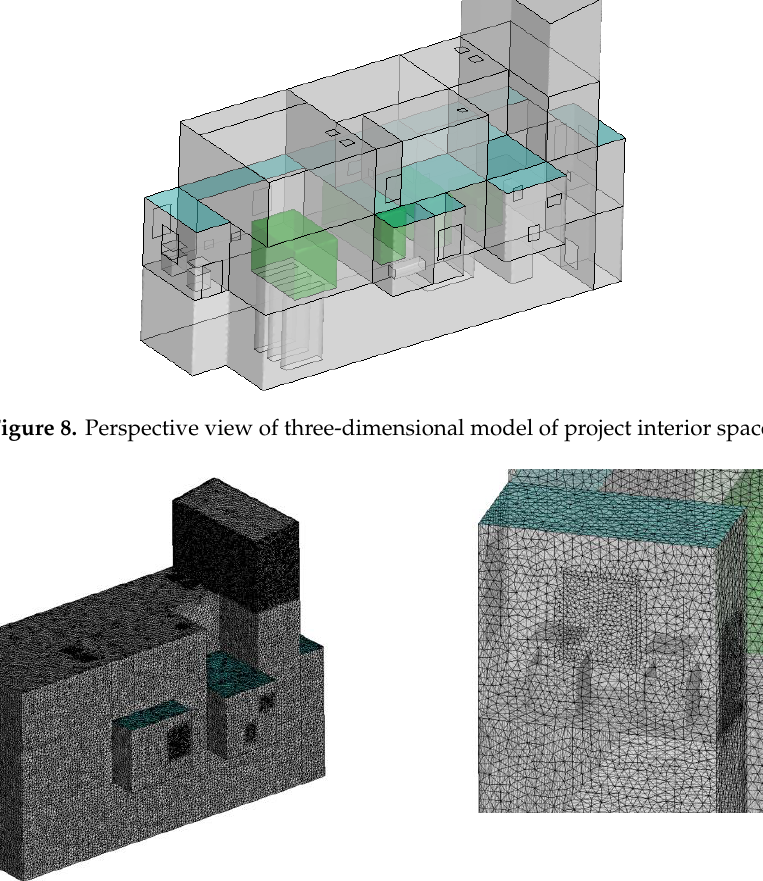
Figure 9. Grid analysis of the overall area inside the building.